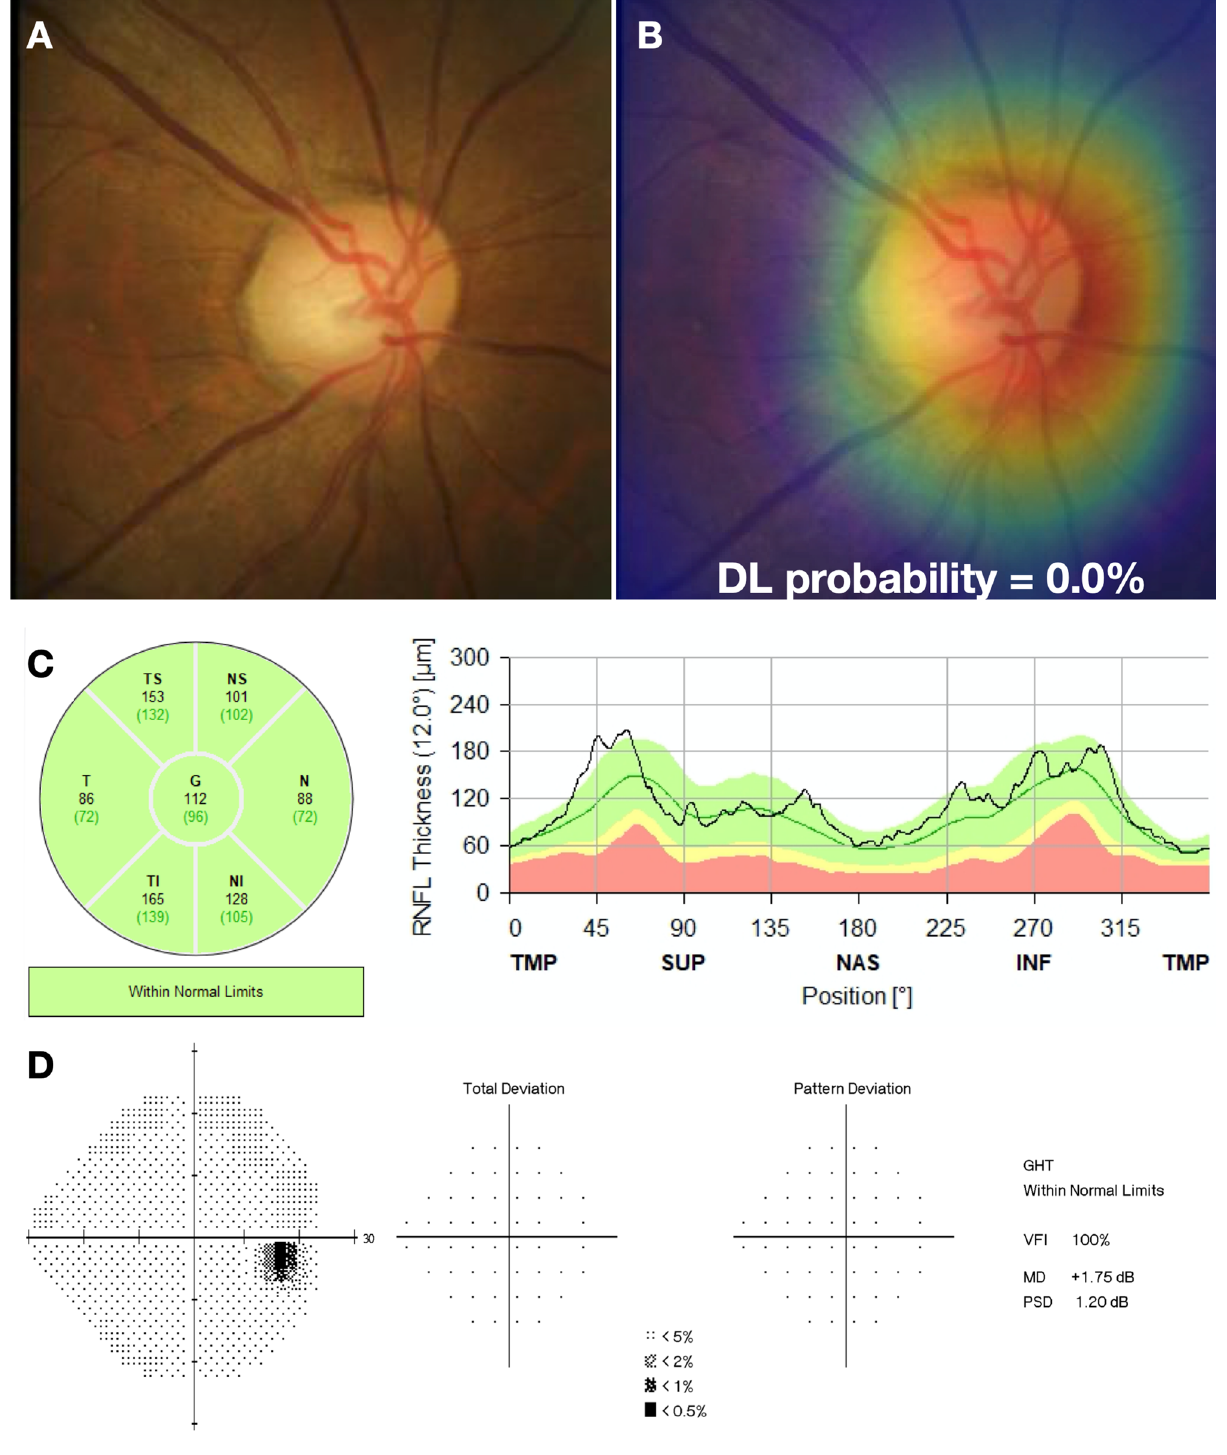
Figure 3. Example of a normal case included in the study. (A) illustrates the fundus photo used as input for the deep learning (DL) algorithm, which predicted a glaucoma probability of 0.0%. (B) shows the regions that were most important for the classification, in which the heatmap diffusely highlights the optic disc. (C) illustrates the spectral domain optical coherence tomography and (D) the standard automated perimetry, both without